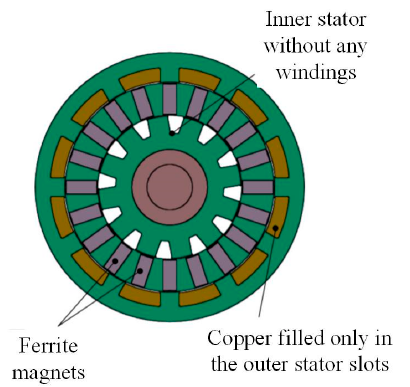
Figure 16. Configuration of a double stator Vernier PM (VPM) machine [39].